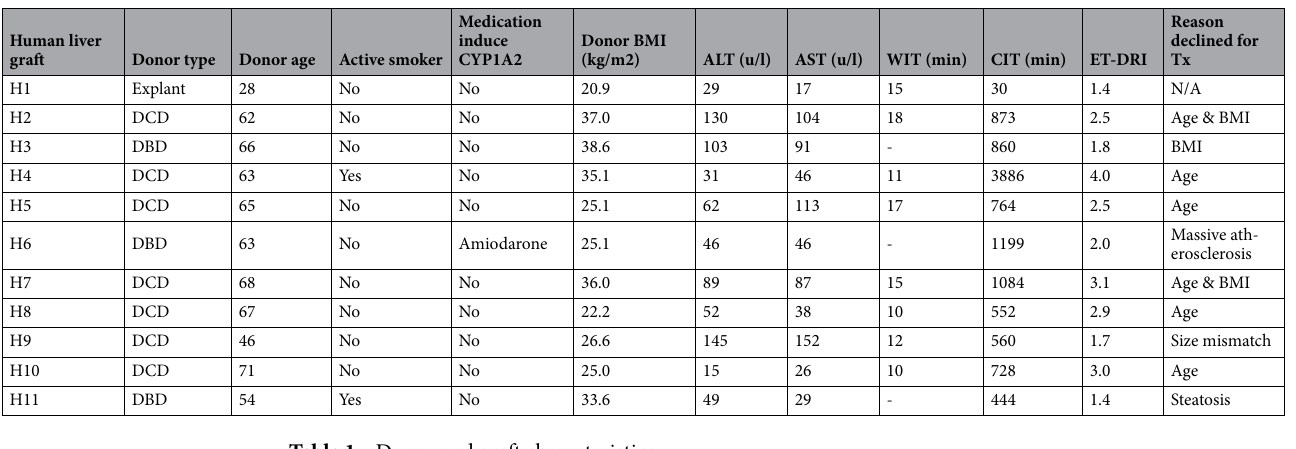
Table 1. Donor and graft